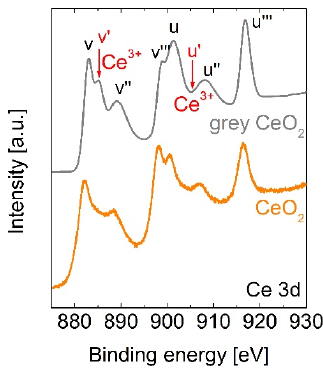
Figure 5. XPS spectra of the CeO 2 samples.